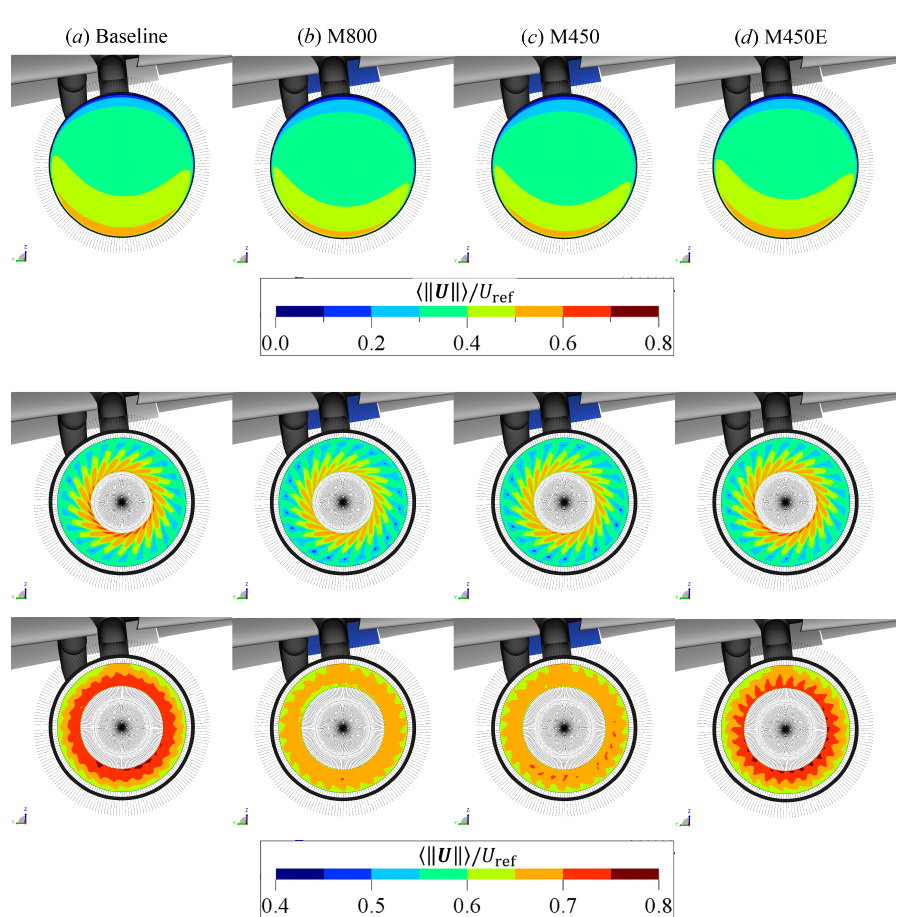
Figure 9. (Front view) Contours of phase-locked average of velocity magnitude ( || U || ) at the SDT inlet ( top row), interstage ( middle row), and outlet ( bottom